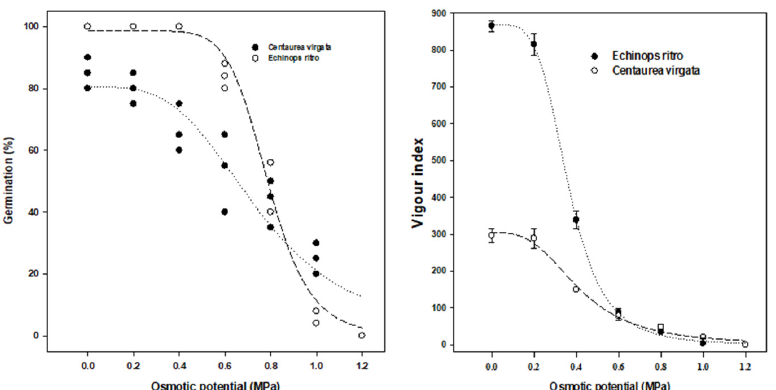
Figure 4. Fitted nonlinear regression model on the data obtained from seed germination and seedling vigor of Echinops ritro and Centaurea virgata under drought